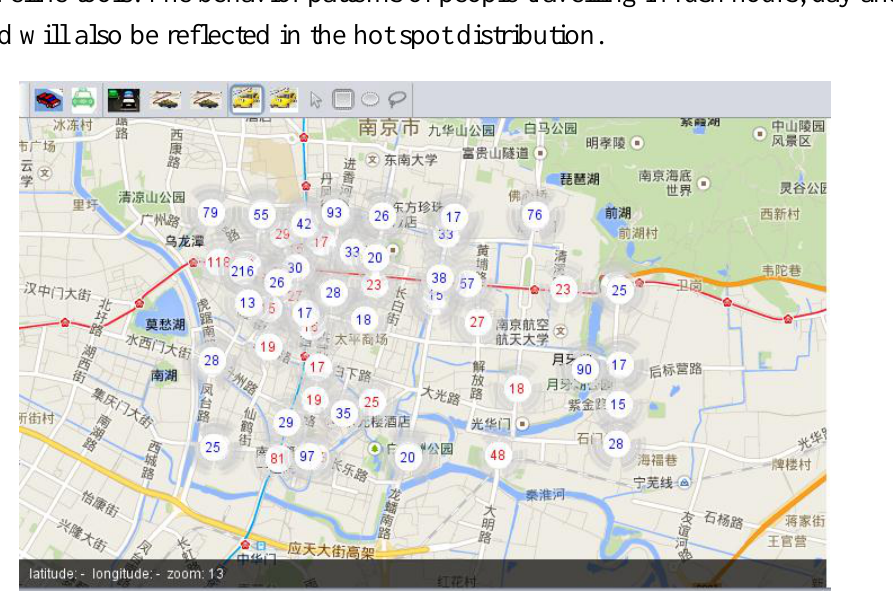
Figure 3. Hot spot clustering